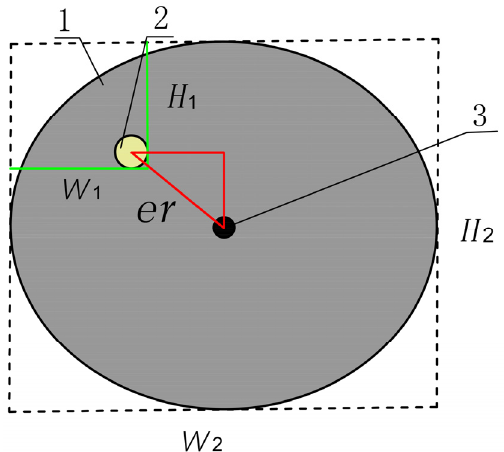
Figure 10. Measurement principle of the probe position error. 1. pineapple eye, 2. probe, and 3. pineapple eye center point.